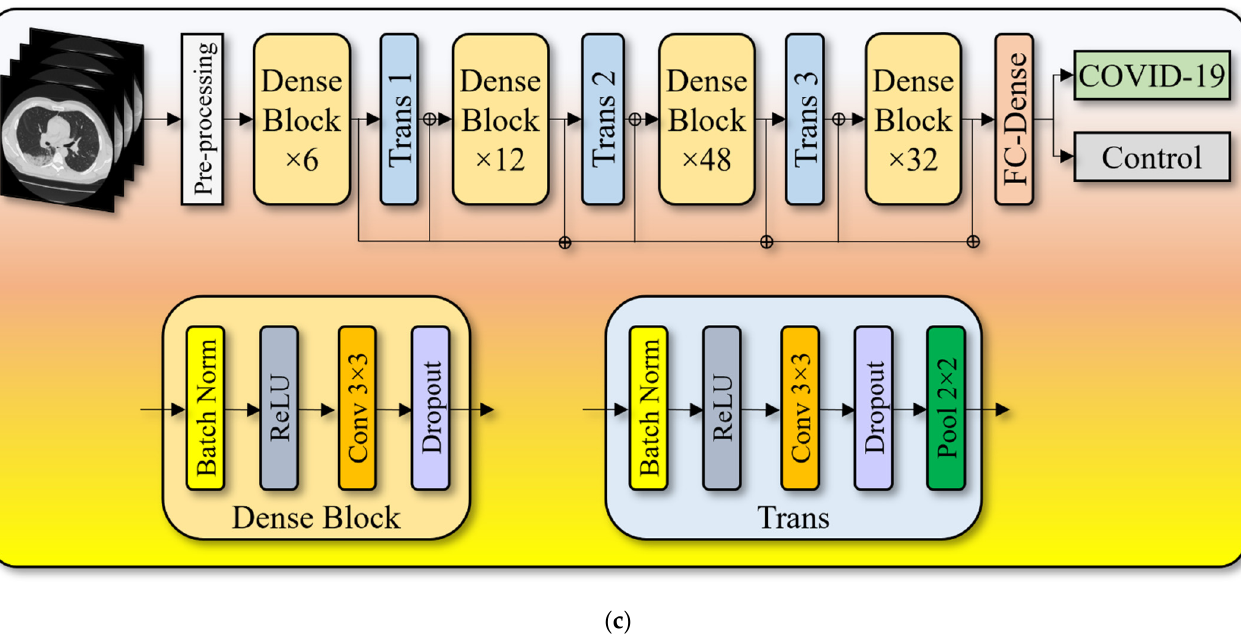
Figure 4. ( a ) DenseNet-121 model. ( b ) DenseNet-169 model. ( c ) DenseNet-201 model.